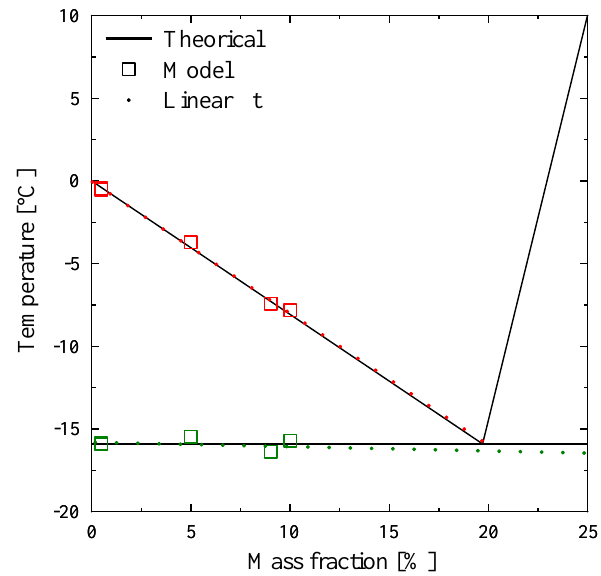
Figure 35. Confrontation of the estimated temperatures ( T liquidus and T E ) with the real phase diagram of H 2 O/NH 4 Cl solution